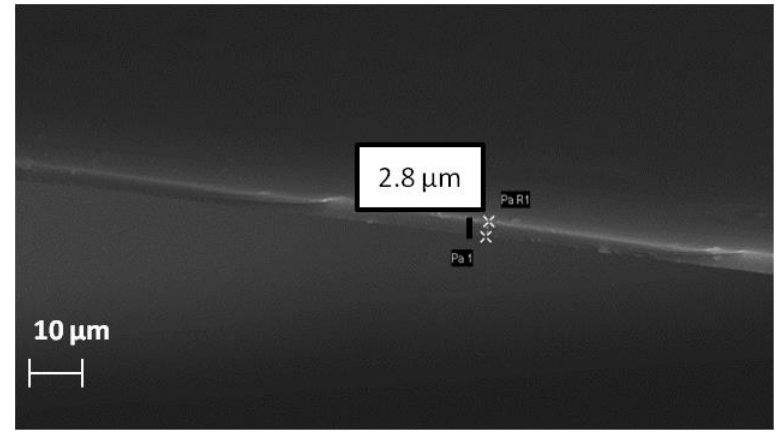
Figure 5. SEM image of PIL containing BF 4− counter anion.